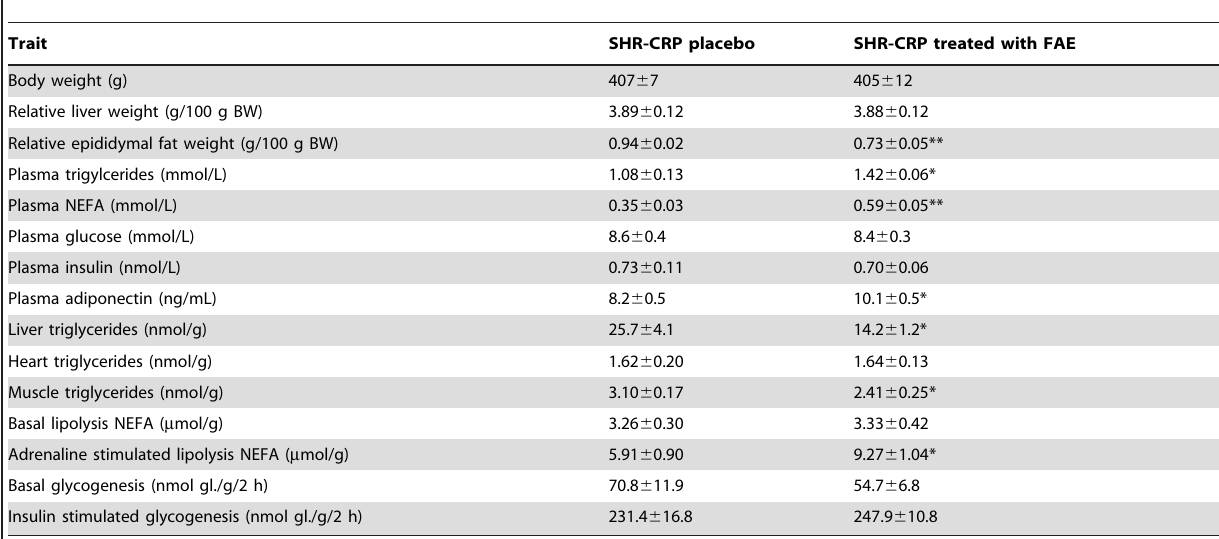
Table 2. Metabolic parameters in SHR-CRP transgenic rats treated with fumaric acid esters (FAE) or placebo.